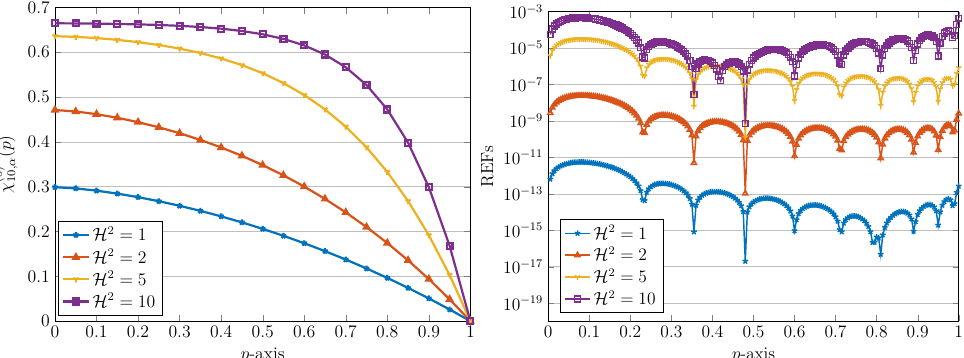
Figure 7. Graphics of numerical solutions obtained via the QLM-GSAPSK technique ( left ) and related REFs ( right ) with R = 10, α = θ , δ = 0.5, and with fractional-orders θ = 1.5, λ = 0.5. Table 6. The outcomes of ∞ error norms and the related ord E θ = 1.5, λ = 0.5, α = θ , and different R .